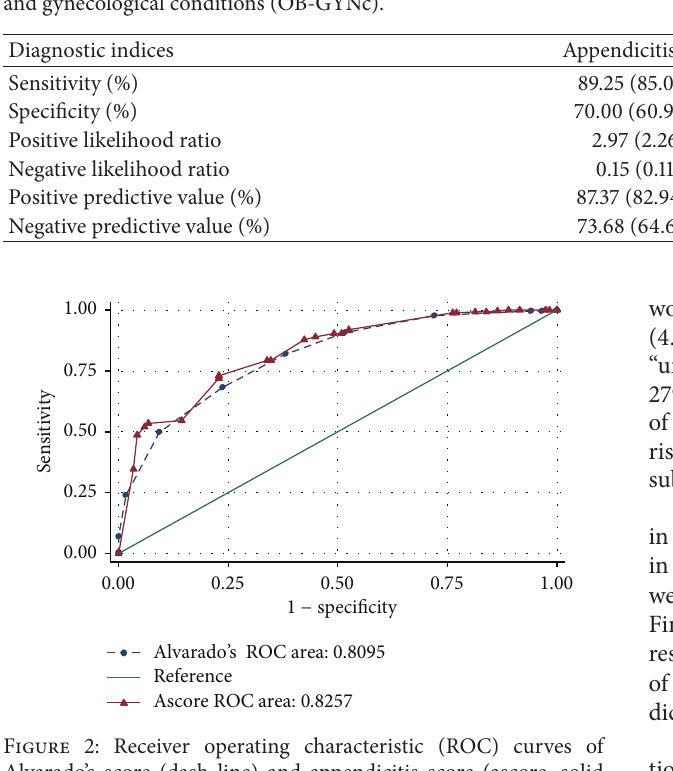
Table 5: Diagnostic indices (and 95% confidence interval; CI) of the scoring scheme for diagnosis of appendicitis and common obstetrics and gynecological conditions (OB-GYNc).